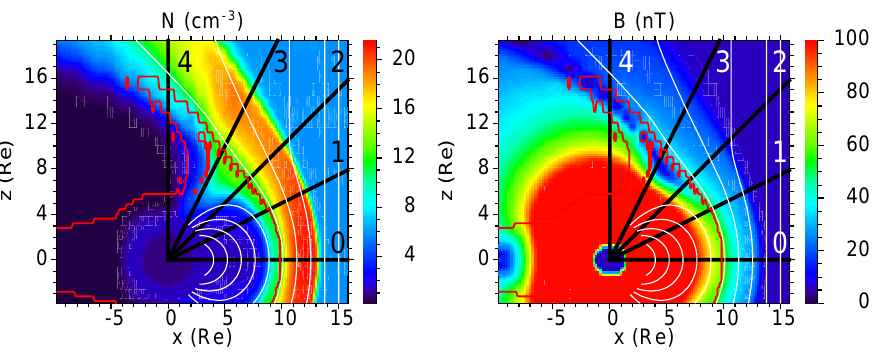
Fig. 9. The plasma density and the magnetic field magnitude in the GSE y=0 plane for Run 1. The open-closed magnetic field boundary is shown as a red zigzag curve and magnetic field lines are shown as white smooth curves in each of the panels. We draw several radially outward straight lines from the center of the Earth. Some plasma and field values along radial lines 0 and 1 are shown in Fig. 10.